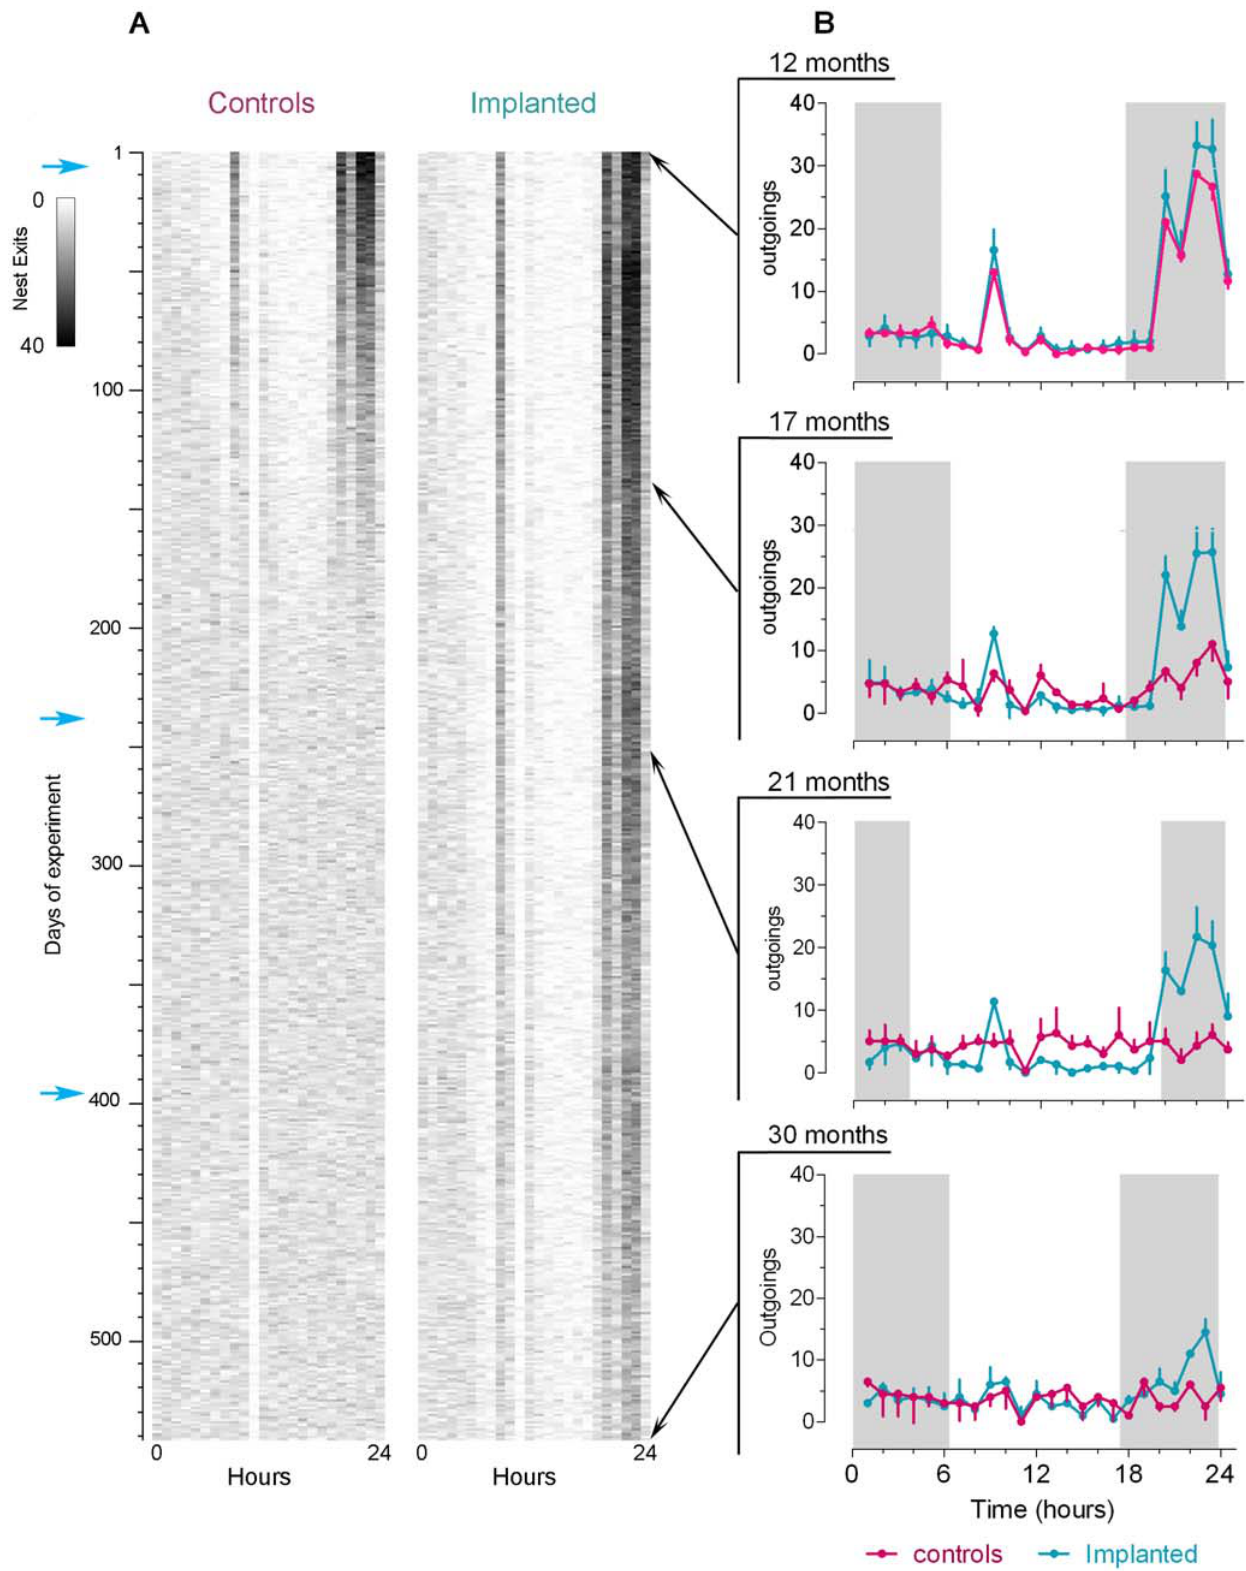
Figure 3. Shrews’ locomotor activity over the duration of the experiment. A: Actograms of a control and a melatonin-implanted shrew from the age of 12 to 30 months. Each line corresponds to one experimental day and there are 24 boxes per line (one box per hour). Nest exits are expressed as a grey scale: the darker the area, the higher the activity for a particular period. Blue arrows indicate each time a new implant was